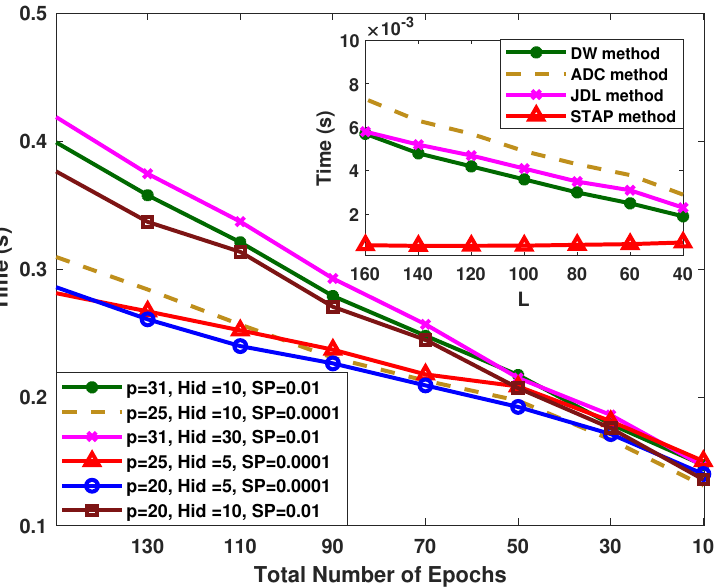
Figure 10. Computation time versus the total number of